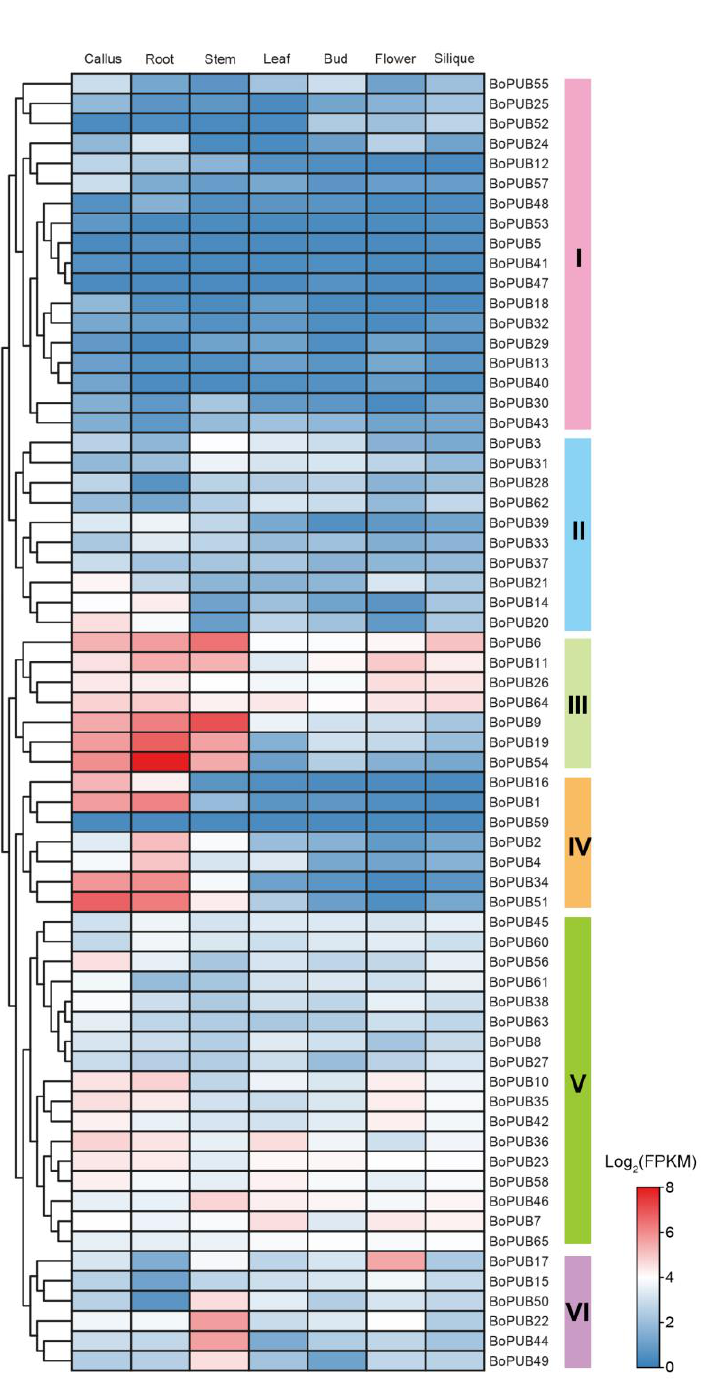
Figure 6. Expression profiles of BoPUB genes in various tissues and organs. The normalized expres- sion data, as fragments per kilobase per million mapped reads (FPKM), of BoPUB genes in seven tissues, including callus, root, stem, leaf, bud, flower, and silique, were obtained from the RNA-seq data of cabbage ( Brassica oleracea var. capitata ). The expression levels of BoPUB genes were plotted in a log2-scaled heatmap. Each row and column in the color heatmap indicate a single gene and tissue, respectively, and their names are shown. Sixty-five BoPUB genes are hierarchically clustered into six groups (Groups I–VI) according to their expression levels. Groups I–VI are highlighted in six different colors,